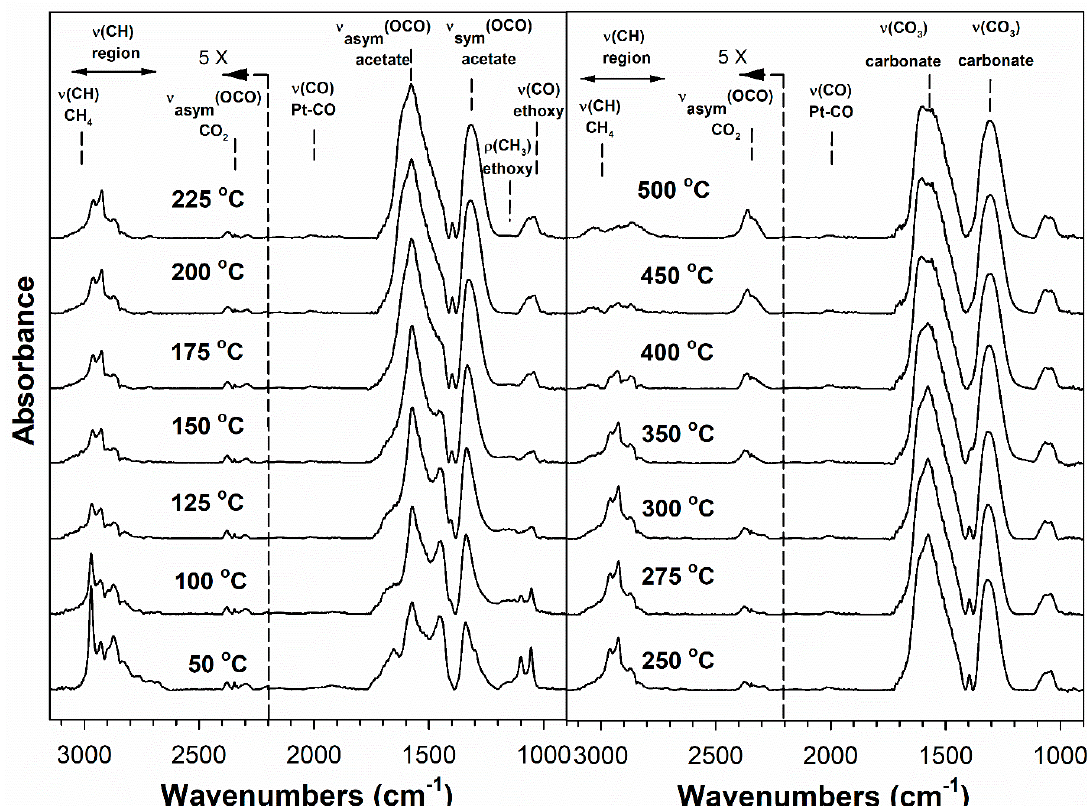
Figure 10. DRIFTS of transient ethanol steam reforming over 10.4% Cs-2% Pt/ZrO 2 .